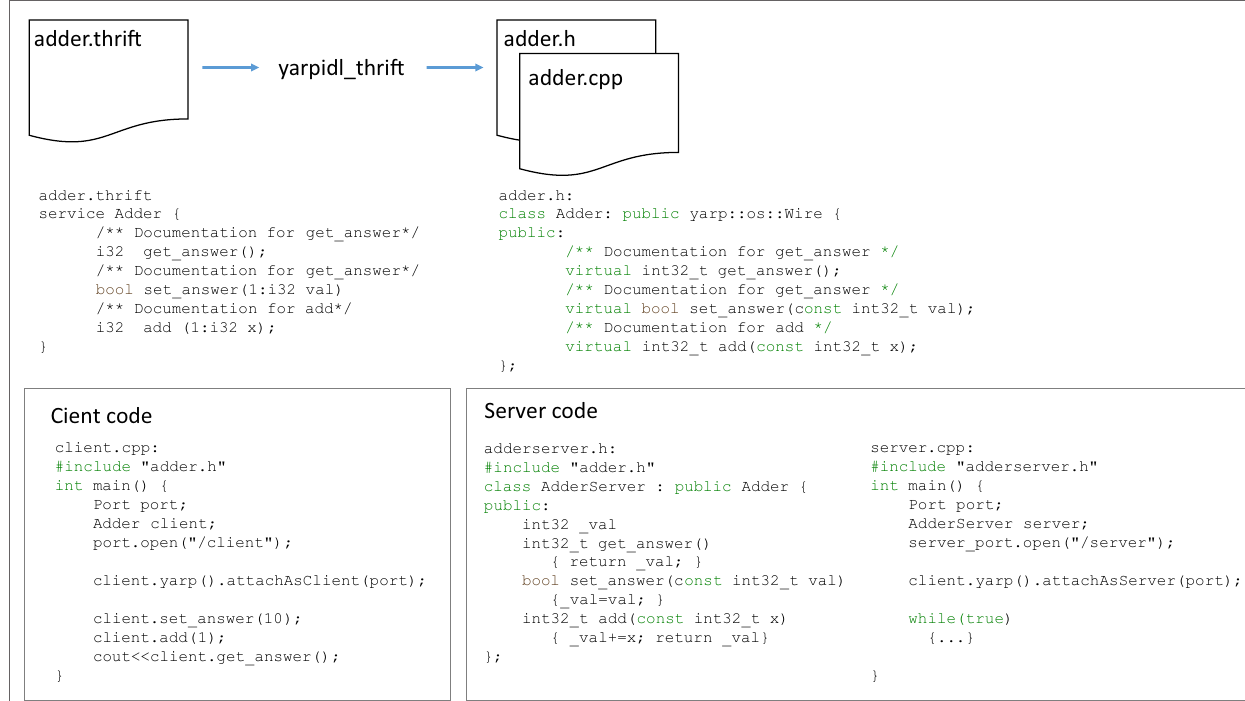
FigUre 1 | service implementation using Thrift . The definition of the service Adder is written using the Thrift IDL ( adder.thrift ); from this file, the yarpidl_thrift compiler generates the corresponding C ++ interface ( adder.h ) and the full implementation of the client ( adder.cpp ). At the client side, function calls take care of marshaling the parameters and shipping them across the YARP network. At the server side, a Port object receives these messages, performs de-marshaling, and invokes the corresponding C ++ function. Notice that comments in the Thrift file are preserved in the C ++ class. Bottom: the client main function instantiates the YARP Port that will be used for the communication, it then instantiates the client object, attaches the Port to it and invokes the service functions as if they were local calls. At the server side, the developers provides implementations for the service functions in an new class ( AdderServer ) that overrides the virtual functions defined in Adder ( adder.h ); it then instantiates the Port that handles the communication and attaches it to an instance of AdderServer . At this point, all messages received by the Port at the server side are dispatched to